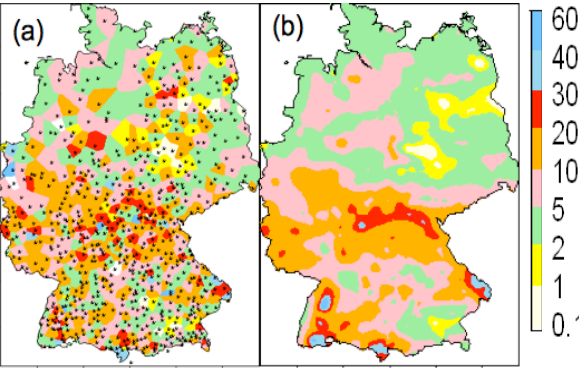
Figure 2: Rain maps for Germany, 1.1.2007 (units in mm). Used interpolation methods are (a) Thiessen Polygones (TP) and (b) Ordinary Kriging (OK).